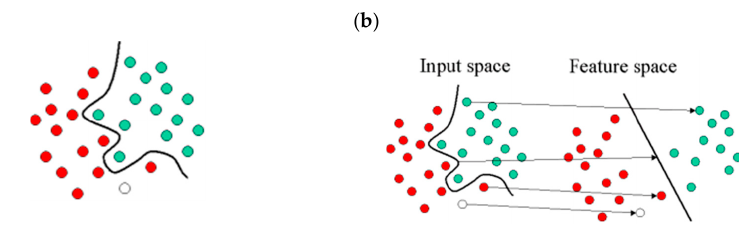
Figure 3. SVM mechanism. ( a ) Optimal classification; ( b ) mapping.